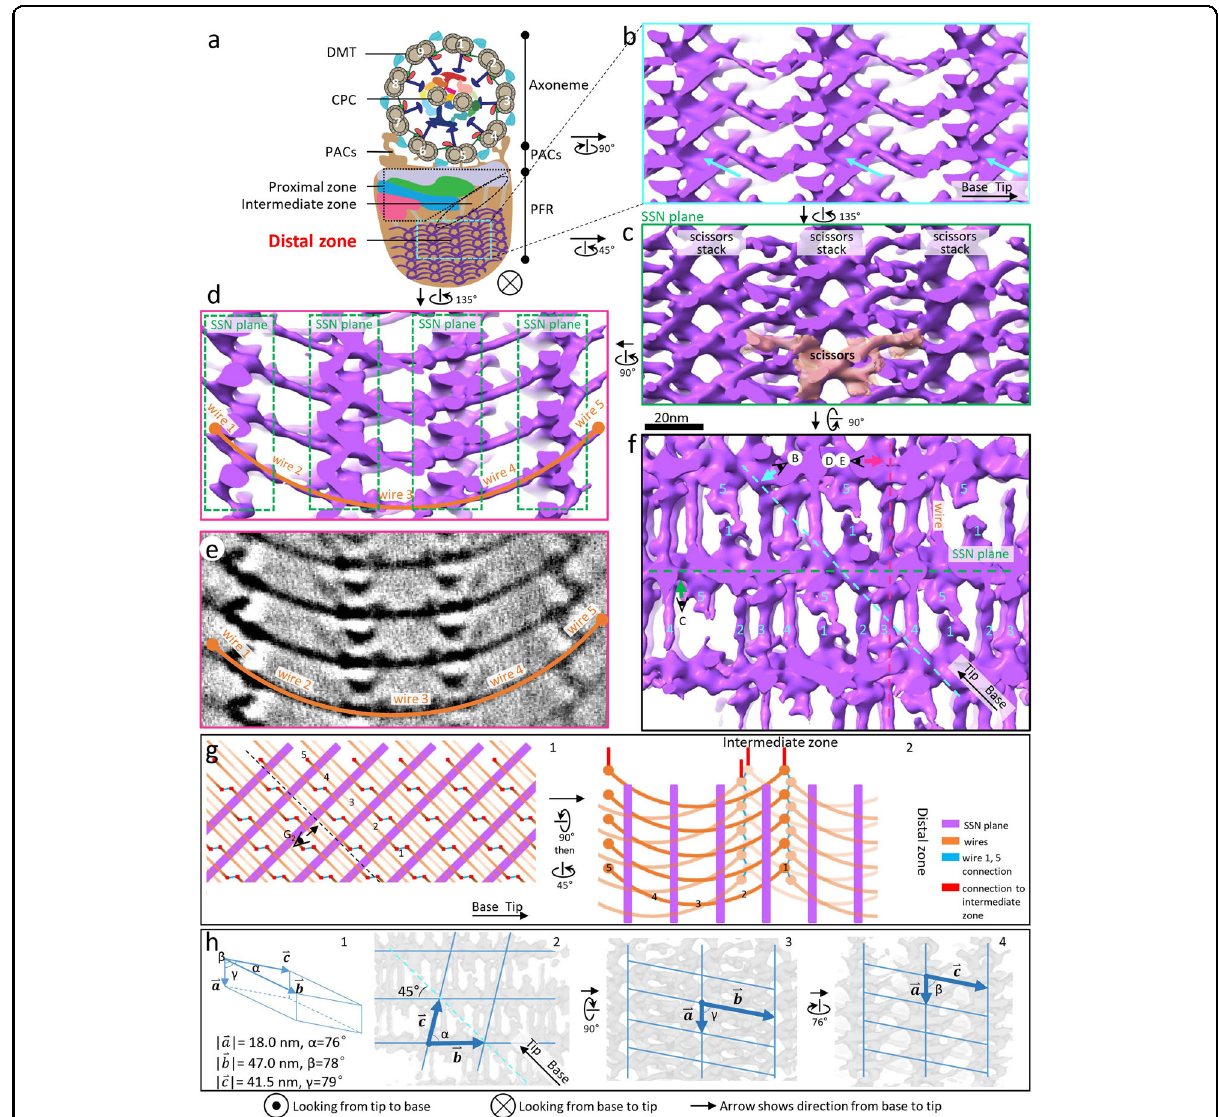
Fig. 2 Structure of the paracrystalline PFR distal zone. a A schematic depicting a cross-section of T. brucei fl agellum viewed from base to tip. b – d , f Shaded surface views of the boxed region in a after rotating as indicated. The “ comb teeth ” densities in Fig. 1b are resolved in greater detail in b and pointed out by cyan arrows in both. b is the side view; c is looking perpendicular to an SSN plane; d is looking parallel to the SSN planes; f is looking from the axoneme to the PFR distal zone. e Same view as d , showing density slice (5 nm thick). In d and e , wires 1 – 5 joining four consecutive SSN planes form a shape of a smiling face. The viewing directions of b – e are indicated within panel f , with letters corresponding to each panel and viewing directions indicated by an arrow next to the eye symbol. Scale bar for panels b – f is shown between panels c and f . g Schematics depicting arrangement of SSN planes (purple) and wires (orange) at the interface of the PFR distal and intermediate zones. The viewing direction of g 1 is the same as that of f except that the horizontal direction is now along the axoneme axis. Decreased intensity of orange wires indicates further away from the viewer. h Geometry schematic illustrating the three vectors of the triclinic crystalline lattice discovered in the distal zone. The semi-transparent gray densities in the background of h 2 is the same as that in f , and rotations for h 3 and h 4 are